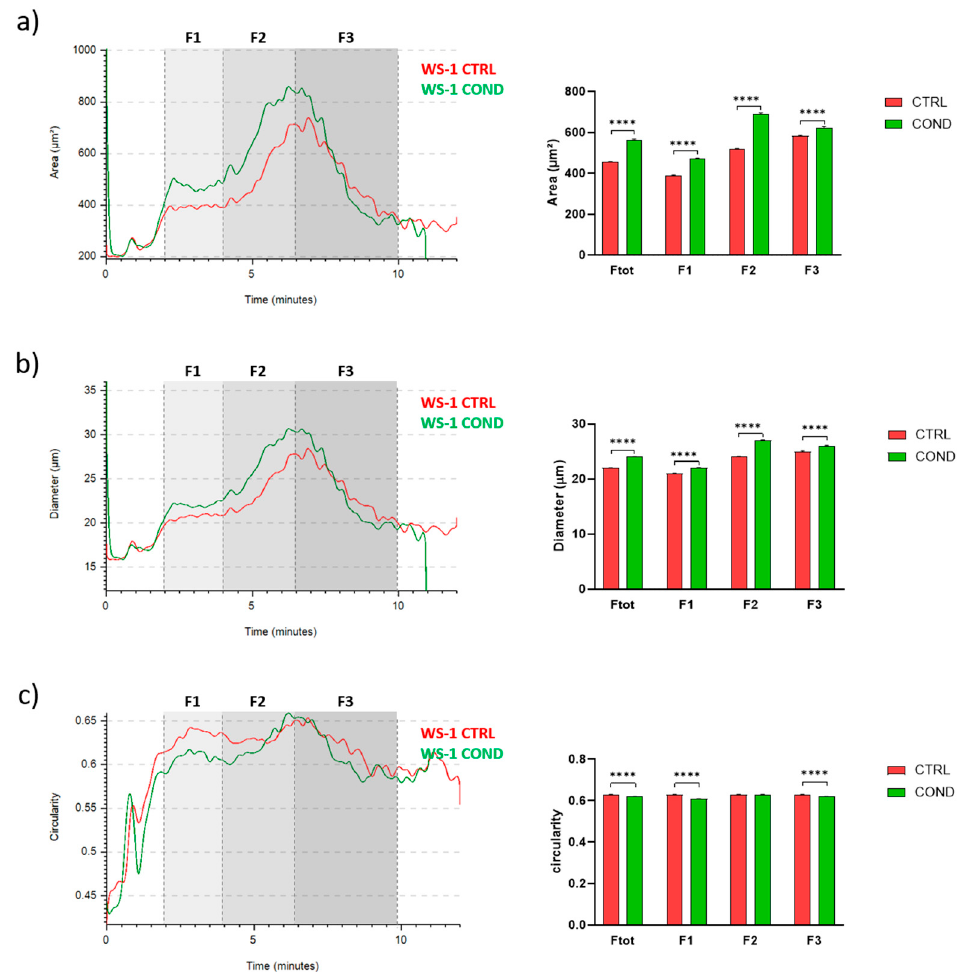
Figure 3 . ( a ) WS-1 CTRL and WS-1 COND area profile ( μ m 2 ) vs. time of analysis in minutes (left panel). Area comparison between different fractions of WS-1 CTRL and WS-1 COND (right panel). ( b ) WS-1 CTRL and WS-1 COND diameter profile ( μ m) vs. time of analysis in minutes (left panel). Diameter comparison between different fractions of WS-1 CTRL and WS-1 COND (right panel). ( c ) WS-1 CTRL and WS-1 COND circularity profile vs. time of analysis in minutes (left panel). Circularity comparison between different fractions of WS-1 CTRL and WS-1 COND (right panel). Data are presented as a mean ± standard error mean (SEM). Statistical analysis was performed using two-way ANOVA test: **** p < 0.0001.